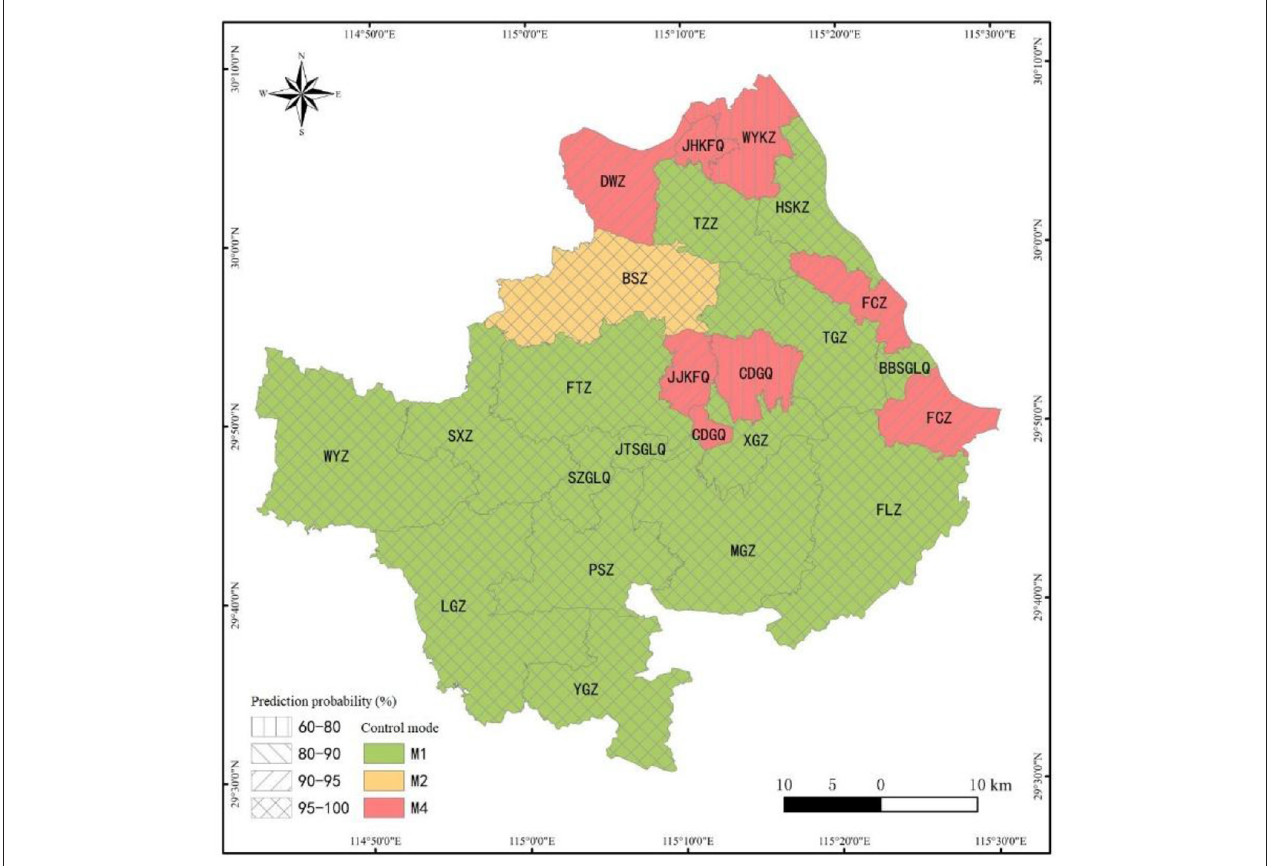
FIGURE 9 | Schematic prediction results of RMCM in the study area (M1: institutional control; M2: remediation; M4: remediation, engineering control, and institutional